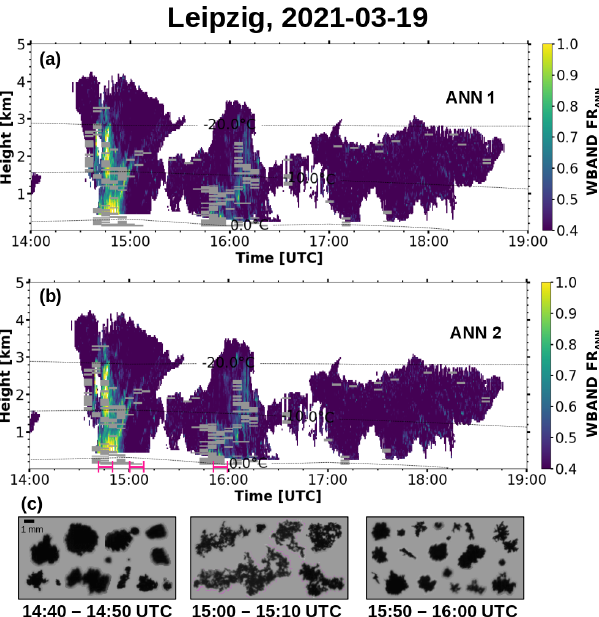
Figure 9. Riming during the case on 19 March 2021 as predicted by (a) ANN 1 (SEW, Ze, skewness, and MDV) and (b) ANN 2 (SEW, Ze, and skewness). The images in panel (c) were taken by the VISSS during the period from 14:40 to 14:50UTC, the period from 15:00 to 15:10UTC, and the period from 15:50 to 16:00UTC, respectively. These periods are marked on the time axis in panel (b) with pink lines. Pixels with EDR above the threshold of 10 − 3m 2 s − 3 are masked in gray in panels (a) and (b)